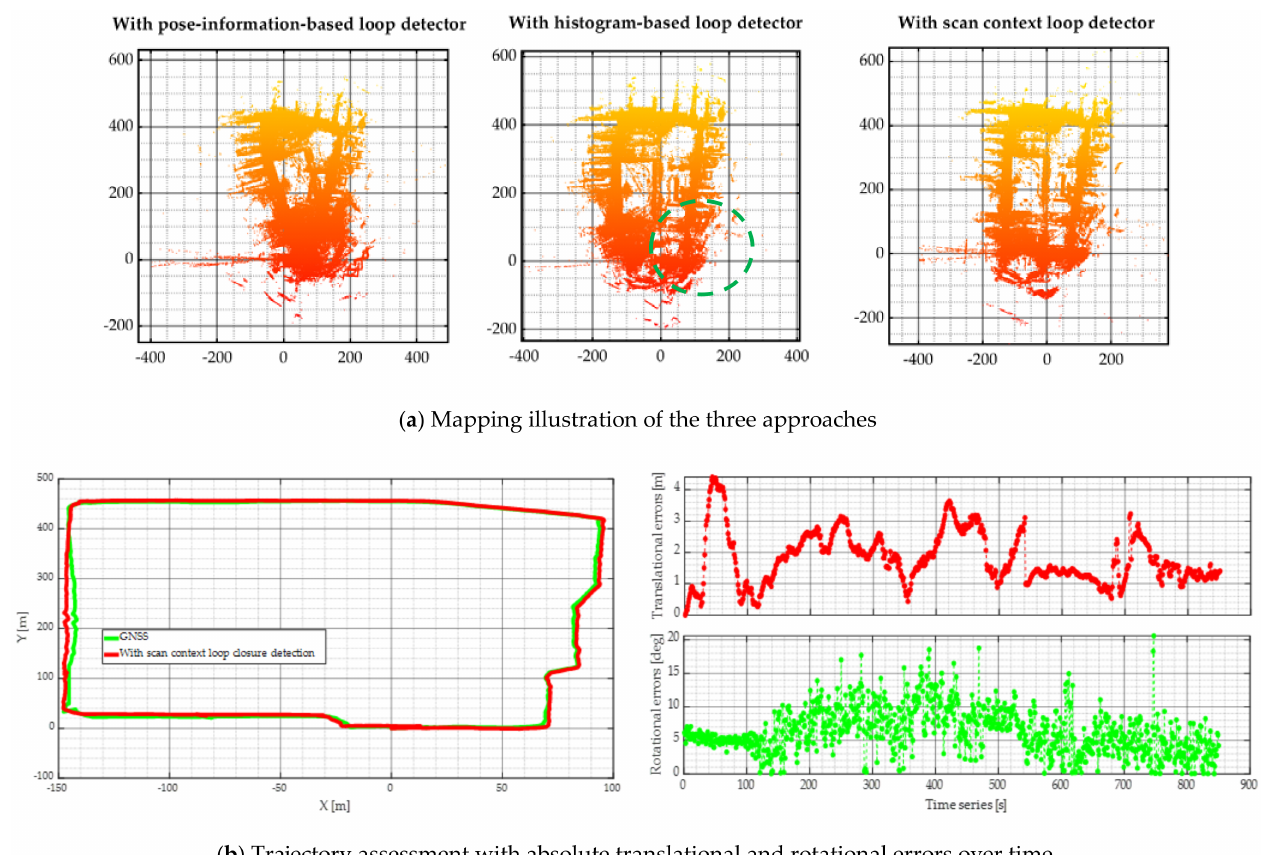
Figure 14. Description of the effects on loop closure